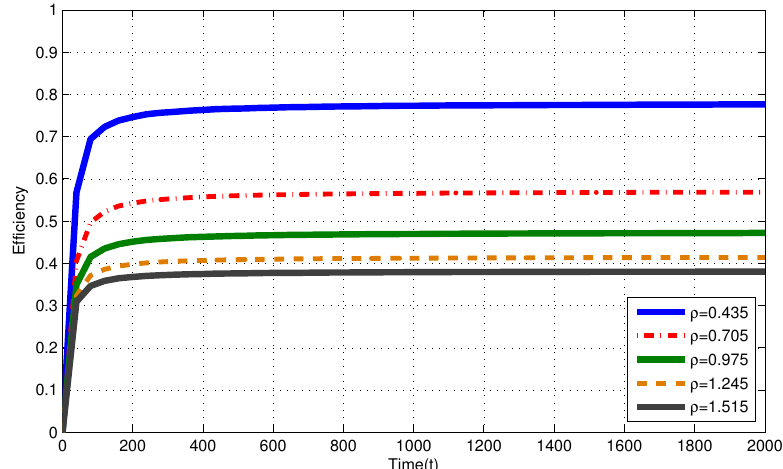
Figure 4. Efficiency of the myopic policy (MP) for Markov EH processes under finite capacity ( B i = 50) battery assumption.